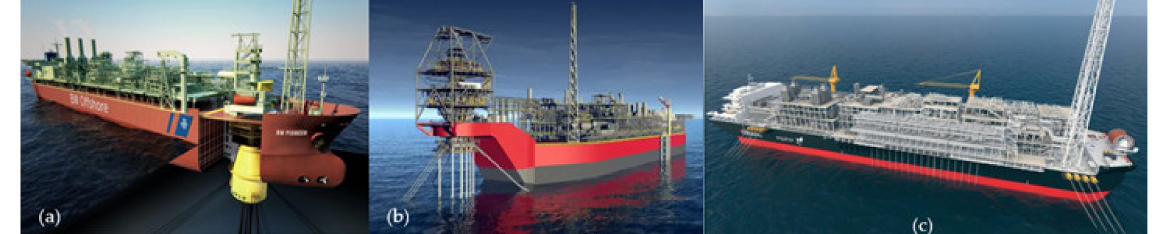
Figure 18. FPSO mooring system: ( a ) Internal turret ( b ) external turret, and ( c ) spread mooring